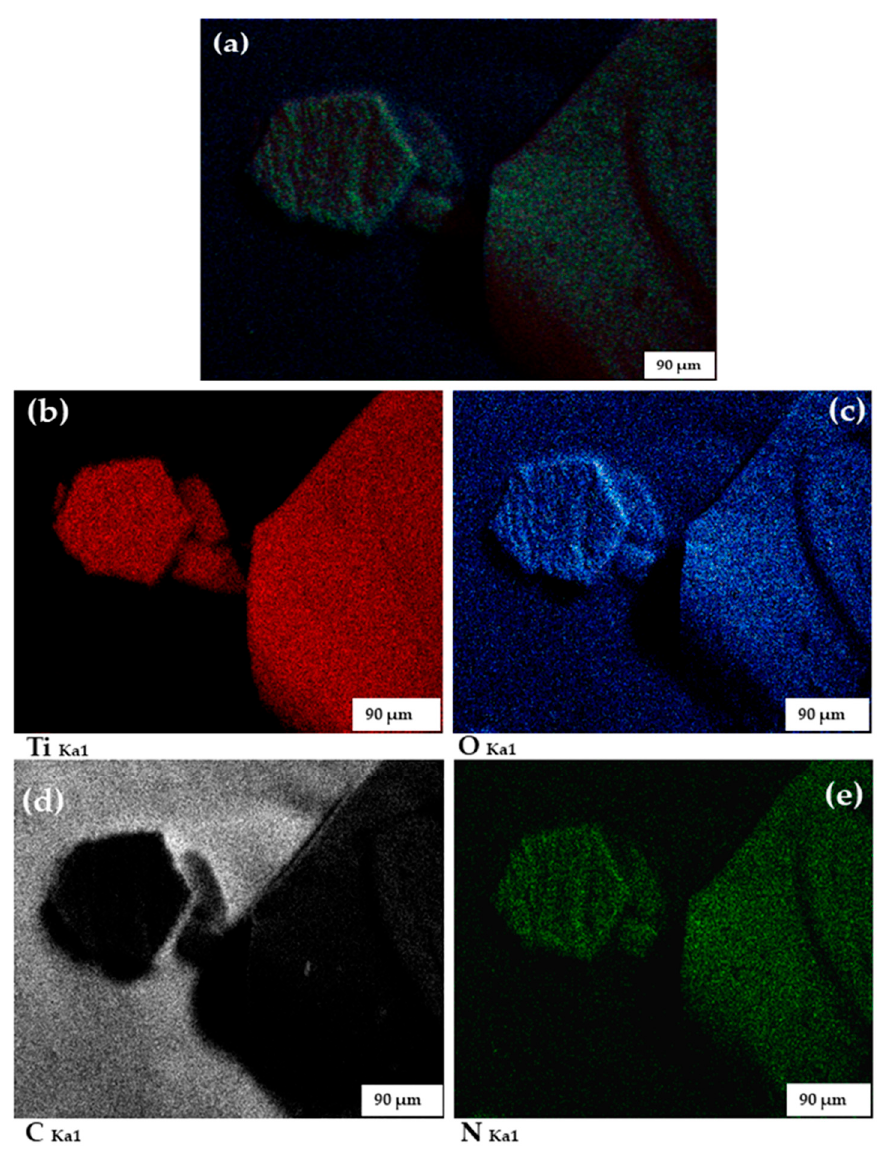
Figure 3. Energy dispersive spectroscopy (EDS) mapping micrographs of SS and anticorrosion meshes coated with C-N-TiO 2 nano catalyst before photo catalysis process (( a ) = selected C-N-TiO 2 coated sample; ( b – e ) denote the presence of, Ti, O, C & N, respectively in the C-N-TiO 2 coated sample).